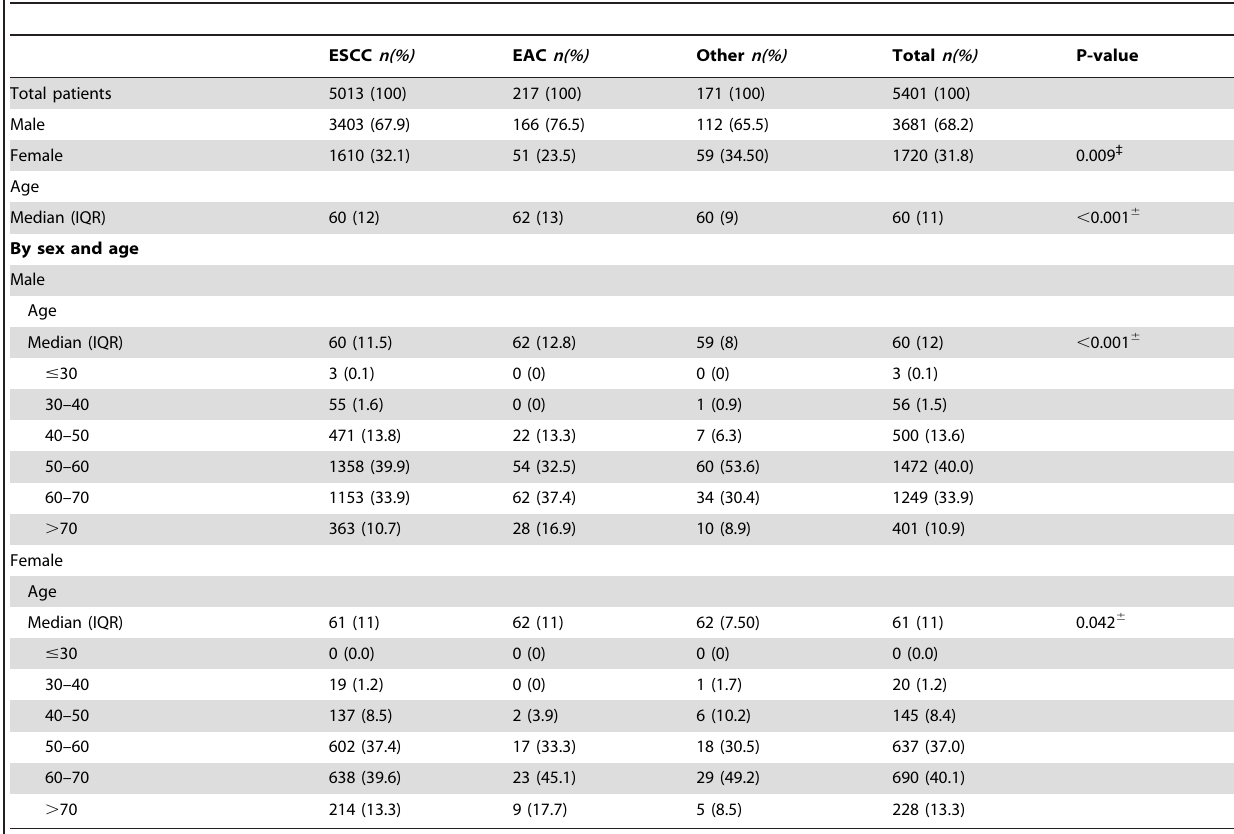
Table 1. Distribution of esophageal squamous cell carcinoma (ESCC) and esophageal adenocarcinoma (EAC) by sex and